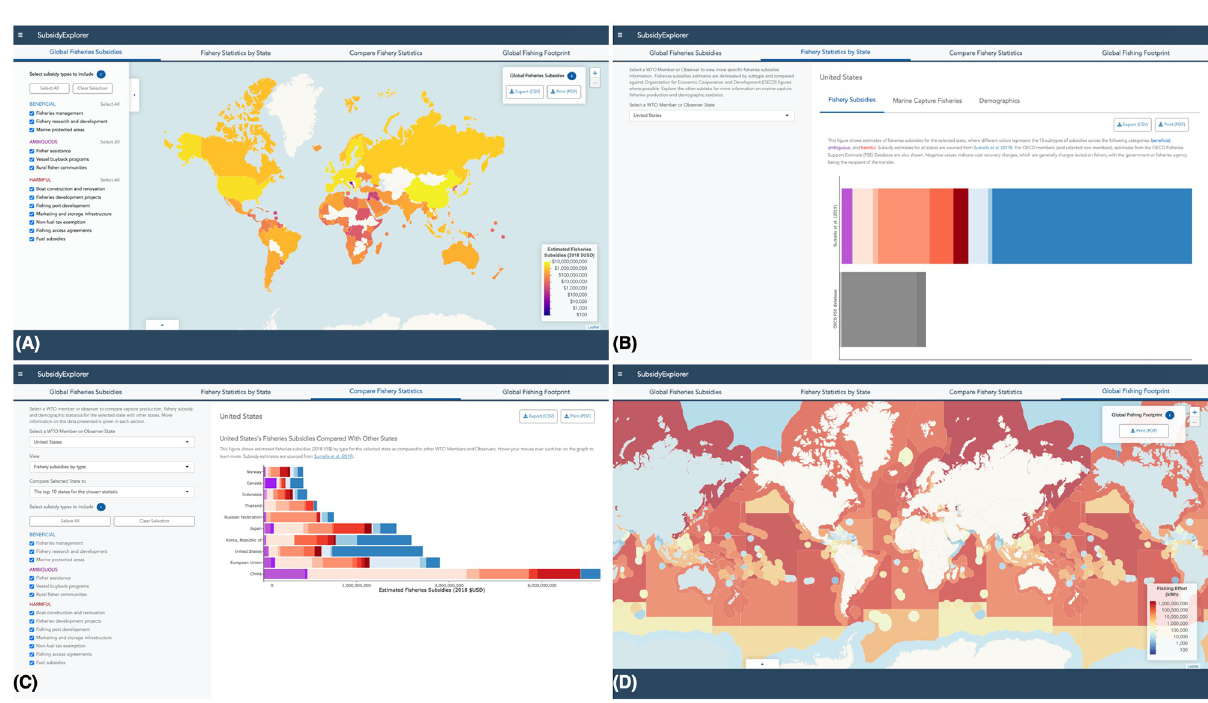
Fig 4. Explore More About Fisheries Subsidies: Data exploration portal. The second section of SubsidyExplorer serves to satisfy the tool’s secondary objective: to allow users to view and interact with data on fisheries subsidies in the context of other relevant fisheries information. Within this section, the user can (A) explore data on subsidy provisioning by country, (B) learn more about the makeup of fisheries subsidies provided by different countries (as well as other types of fisheries and demographic data), (C) compare absolute and relative metrics across countries, and (D) explore patterns of fishing effort globally. Land boundaries depicted in (A) and (D) were made with Natural Earth (free vector and raster map data @ naturalearthdata.com). Marine boundaries depicted in (D) were made using the Maritime Boundaries Geodatabase, version 10 [49]. Republished from www.subsidyexplorer.com under a CC BY license with permission from UCSB, original copyright 2021.